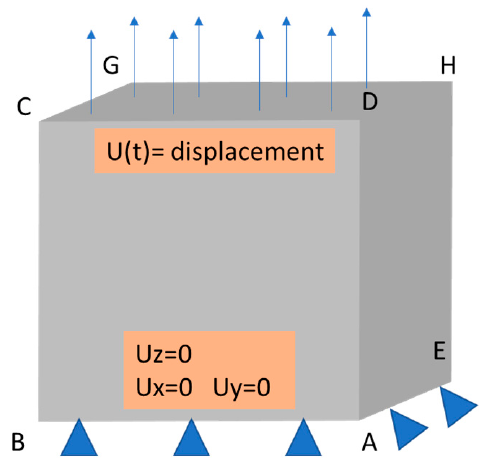
Figure 5. PRVE and BC Figure 5. P RVE and BC Schematics.